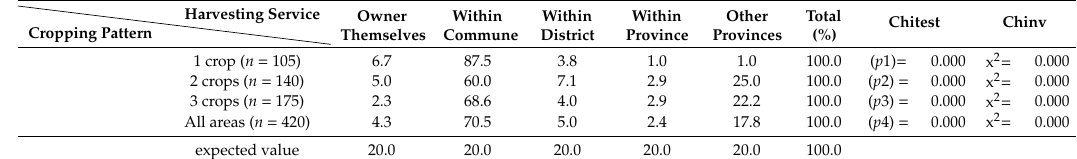
Table 15. Origin of farm machinery service supplier for harvesting.by rice cropping pattern (%). Harvesting Service Cropping Pattern